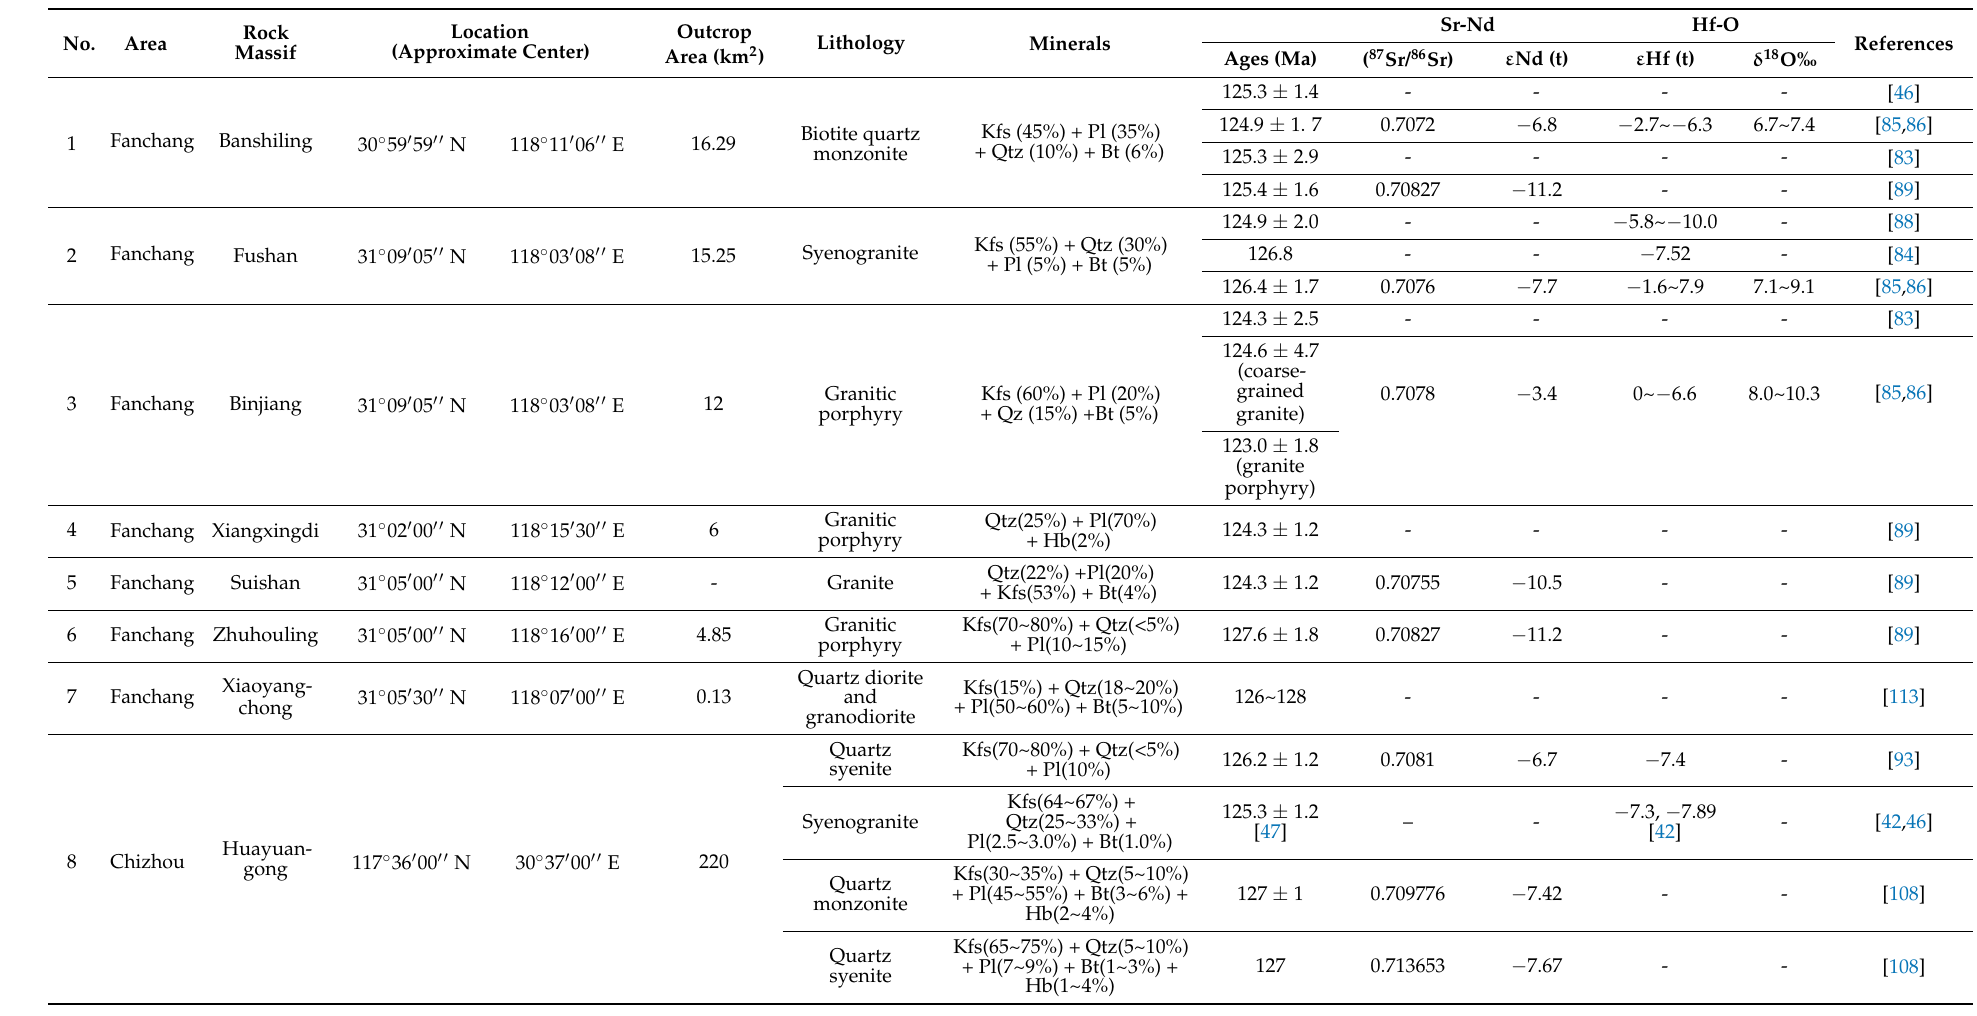
Table 1. Summary of A-type granites in